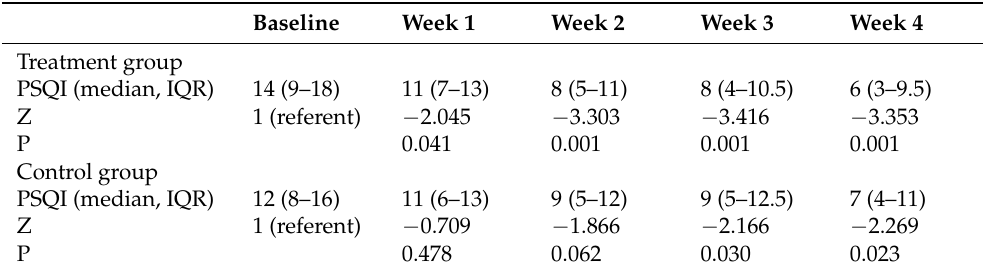
Table 2. Results of weekly PSQI scores for the treatment group and the control